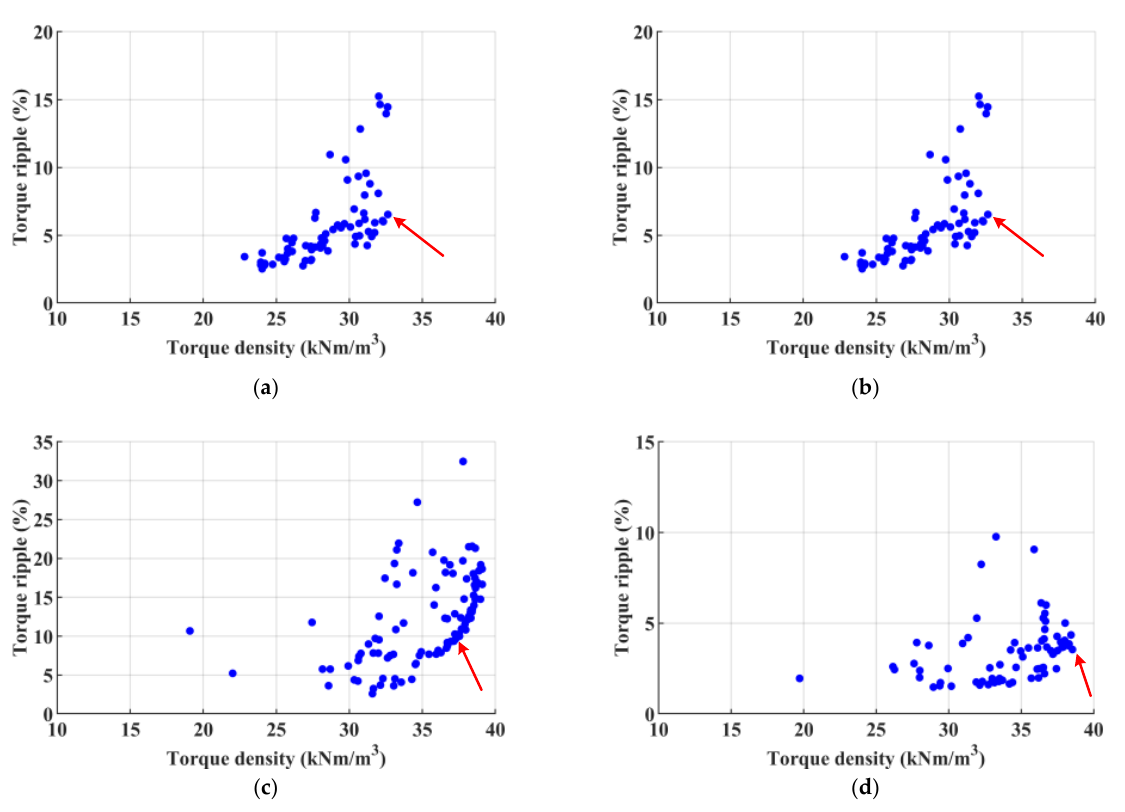
Figure 9. The Pareto fronts of the GA. ( a ) 12/7; ( b ) 12/8; ( c ) 12/10; ( d ) 12/11.